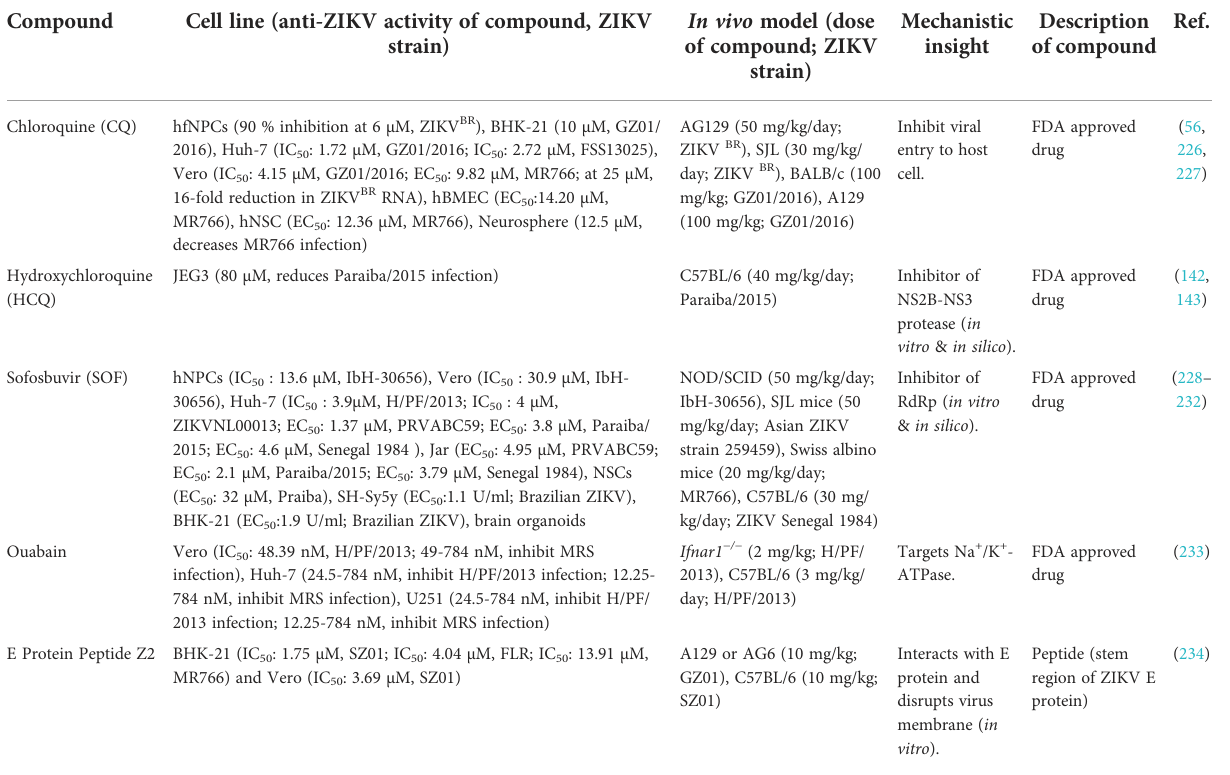
TABLE 2 ZIKV inhibitors that have the potential to inhibit vertical transmission from mother to fetus in a mouse model. Compound Cell line (anti-ZIKV activity of compound, ZIKV